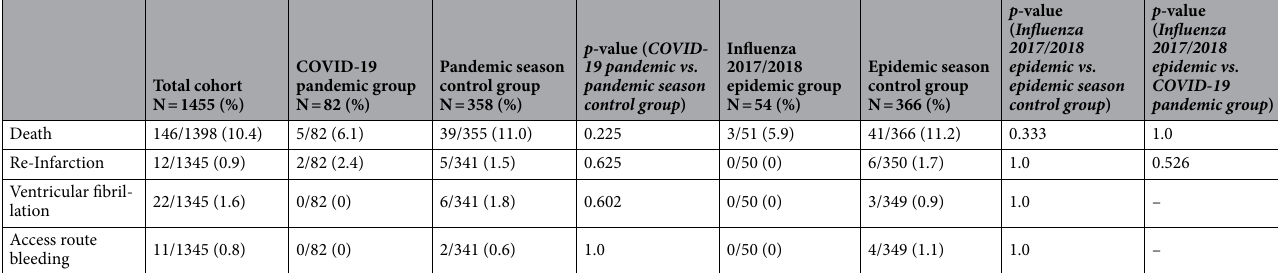
Table 4. Periprocedural complication rates. LAD left artery descending, RD diagonal branch, CFX circumflex artery, RPLS posterolateral artery branch, RCA right coronary artery, LIMA left internal mammary artery, ASA acetylsalicylic acid, Clo Clopidogrel, Pra Prasugrel, Tic Ticagrelor, CK creatin kinase, *: statistical significant difference; –: Testing not